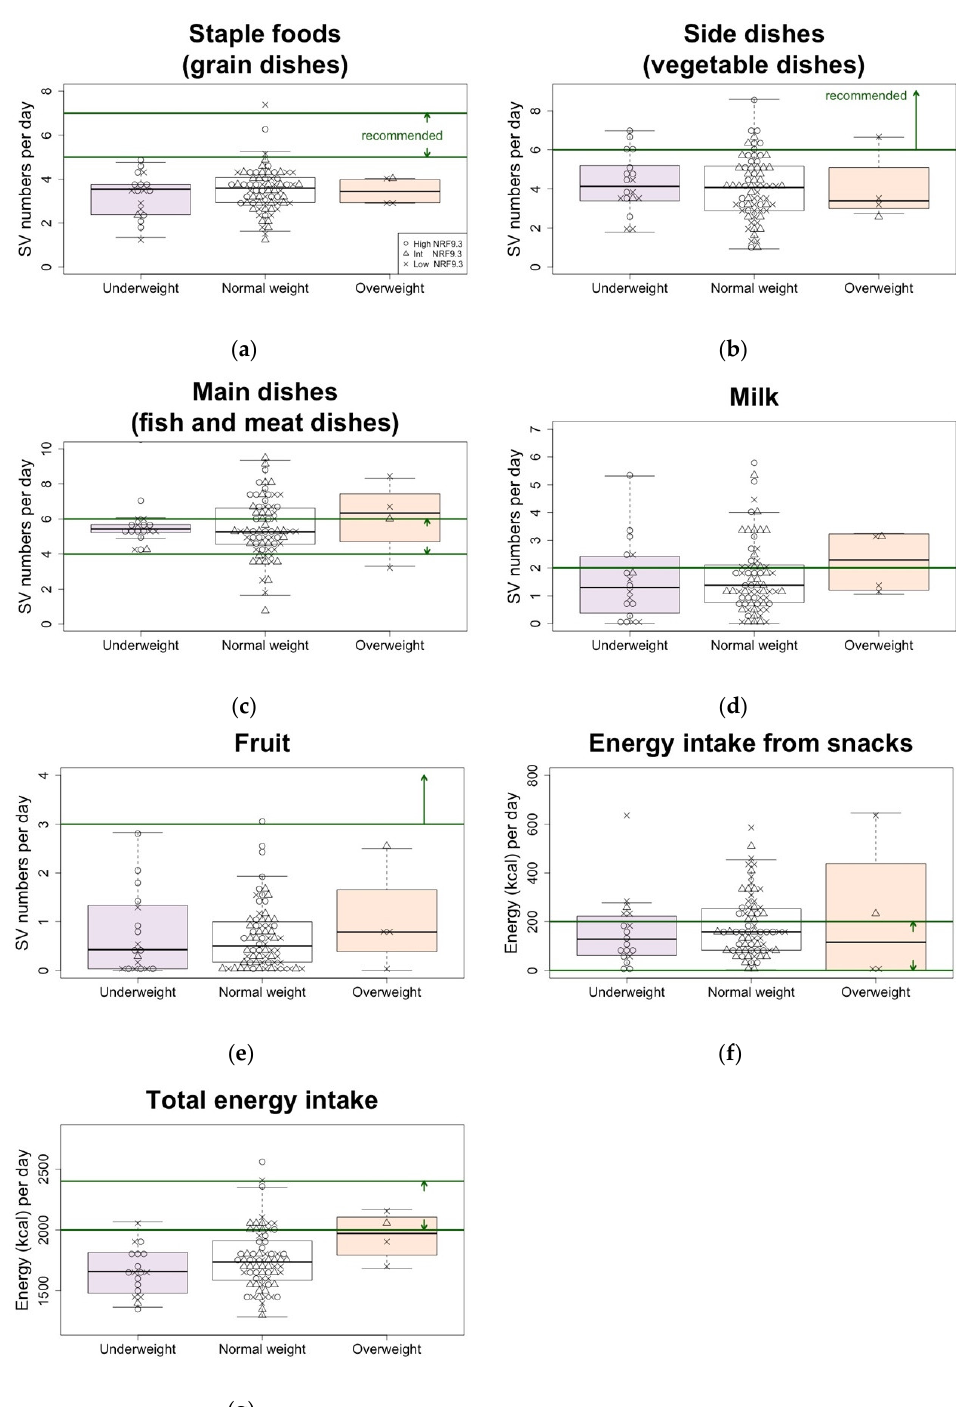
Figure 2. JFGST SV number ( a – e ) and energy intake ( f , g ) according to the pre-pregnancy BMI category, with presentation of the individual’s diet quality status. Each subject ( n = 91) is shown in the box-and-whisker plots, with the boxes indicating the median and interquartile range and the whiskers denoting the range. Green solid line indicates the recommended SV number or its recommended range. Light purple, white, and pink indicate underweight, normal weight, and overweight. Open circles, open triangles, and crosses indicate high, intermediate, and low NRF9.3 scores, respectively, in order to show the relation between food intake and overall diet quality. JFGST, Japanese Food Guide Spinning Top; SV, serving; NRF9.3, Nutrient Rich-Food Index 9.3; BMI, body mass